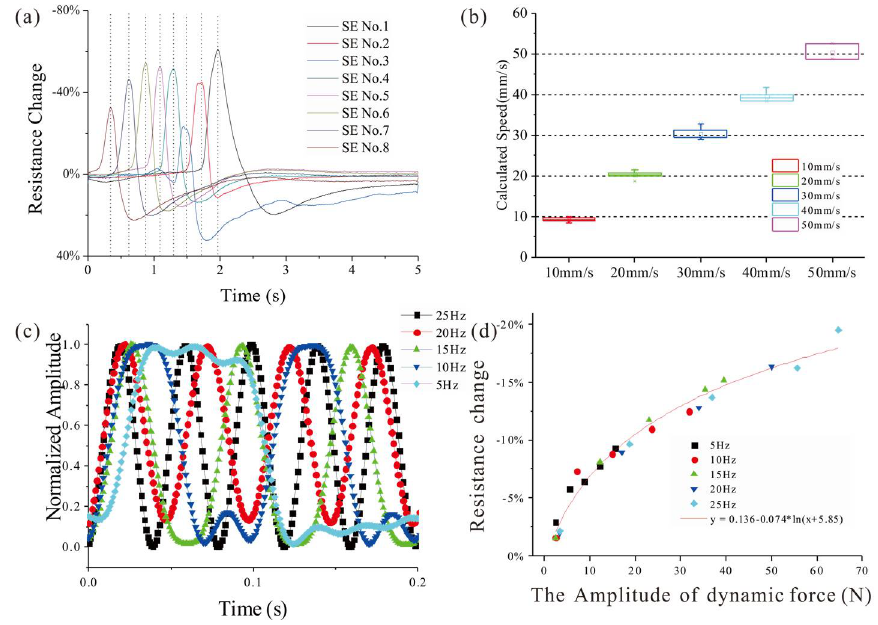
Figure 11. ( a ) Output of parallel SEs (CDoE is 1 mm) under a sliding of 10 mm/s filtered by 30 Hz low-pass; ( b ) Calculated speed from the time difference of output’s peak between adjacent SEs; ( c ) Normalized output of a SE under sine indentations with different frequencies filtered by 30 Hz low-pass; ( d ) The responses of the SE to sine indentations with different frequencies.